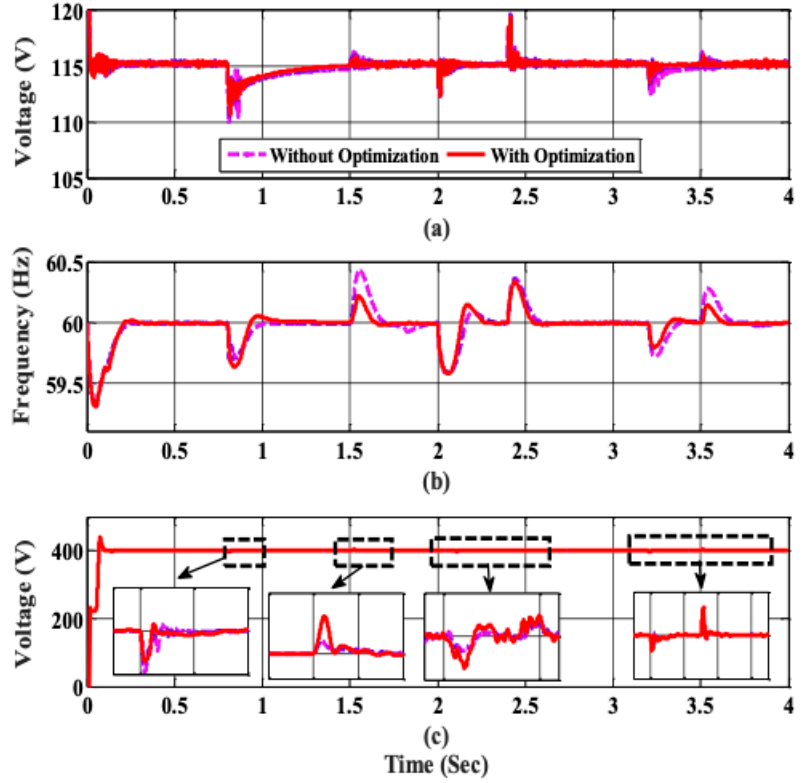
Figure 14. ( a ) AC voltage (RMS value) of phase a ( b ) AC side frequency level ( c ) DC voltage level.